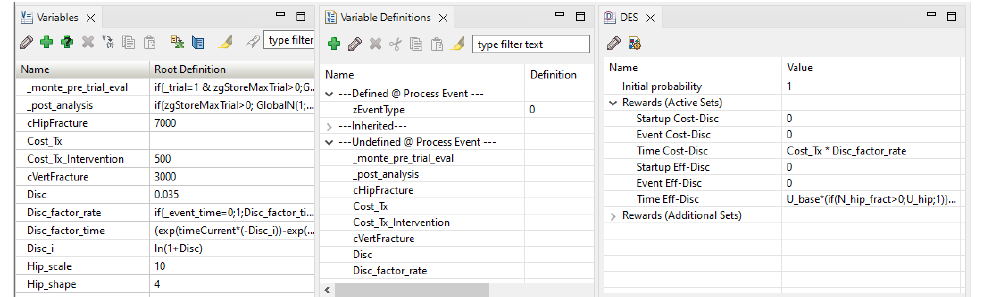
Figure A10. TreeAge’s bottom pane, showing the variables and the DES properties for the ‘Time’ node.